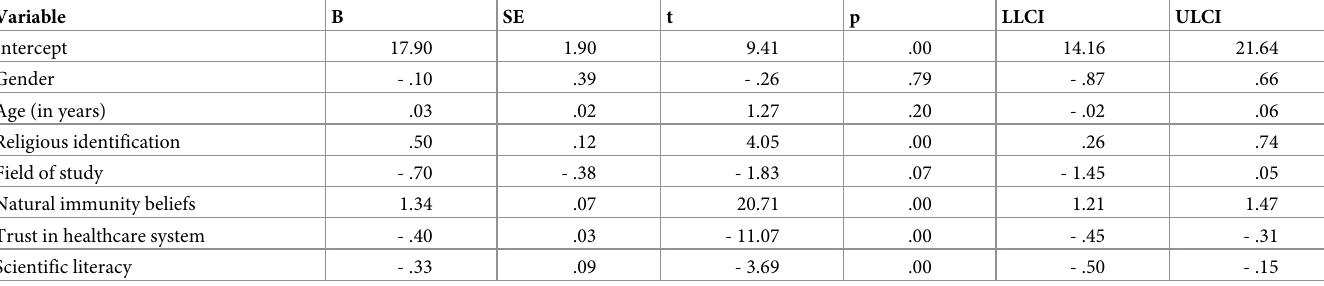
Table 6. Linear regression analysis with the result on the vaccine conspiracy beliefs scale as the criterion variable.